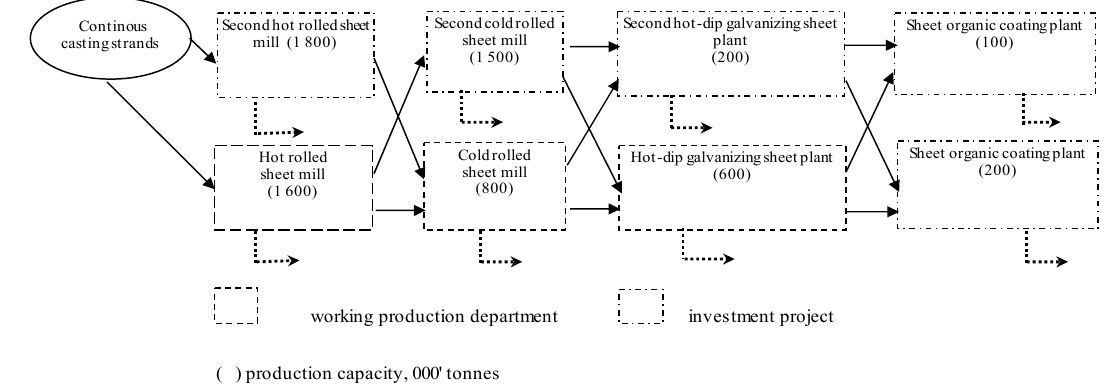
Fig. 4. Diagram of the analyzed production setup